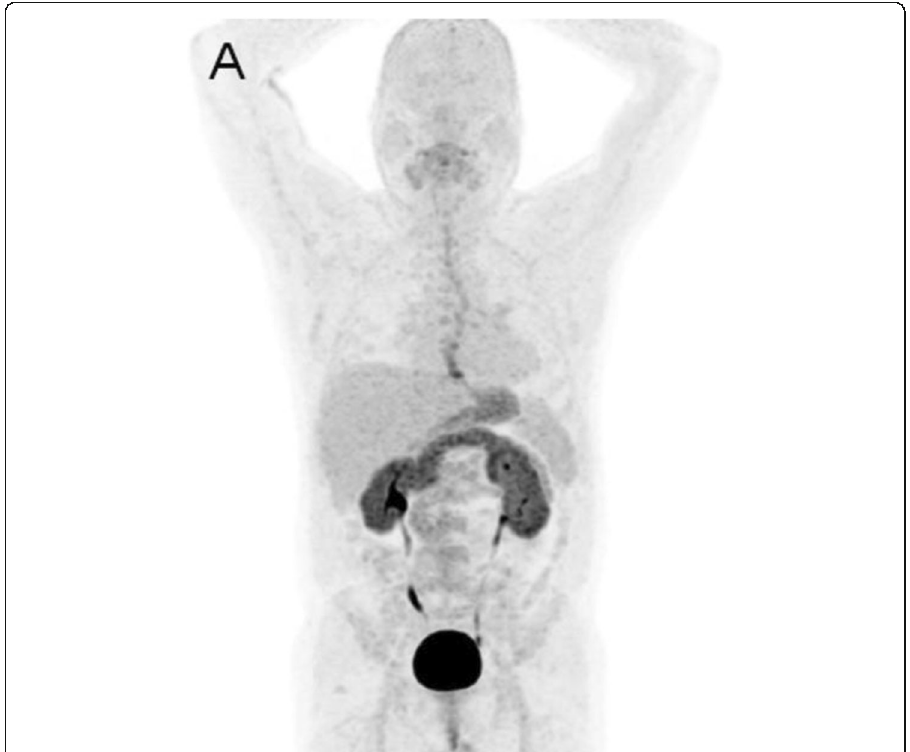
Fig. 44 Physiological biodistribution of 11 C 5-HTP